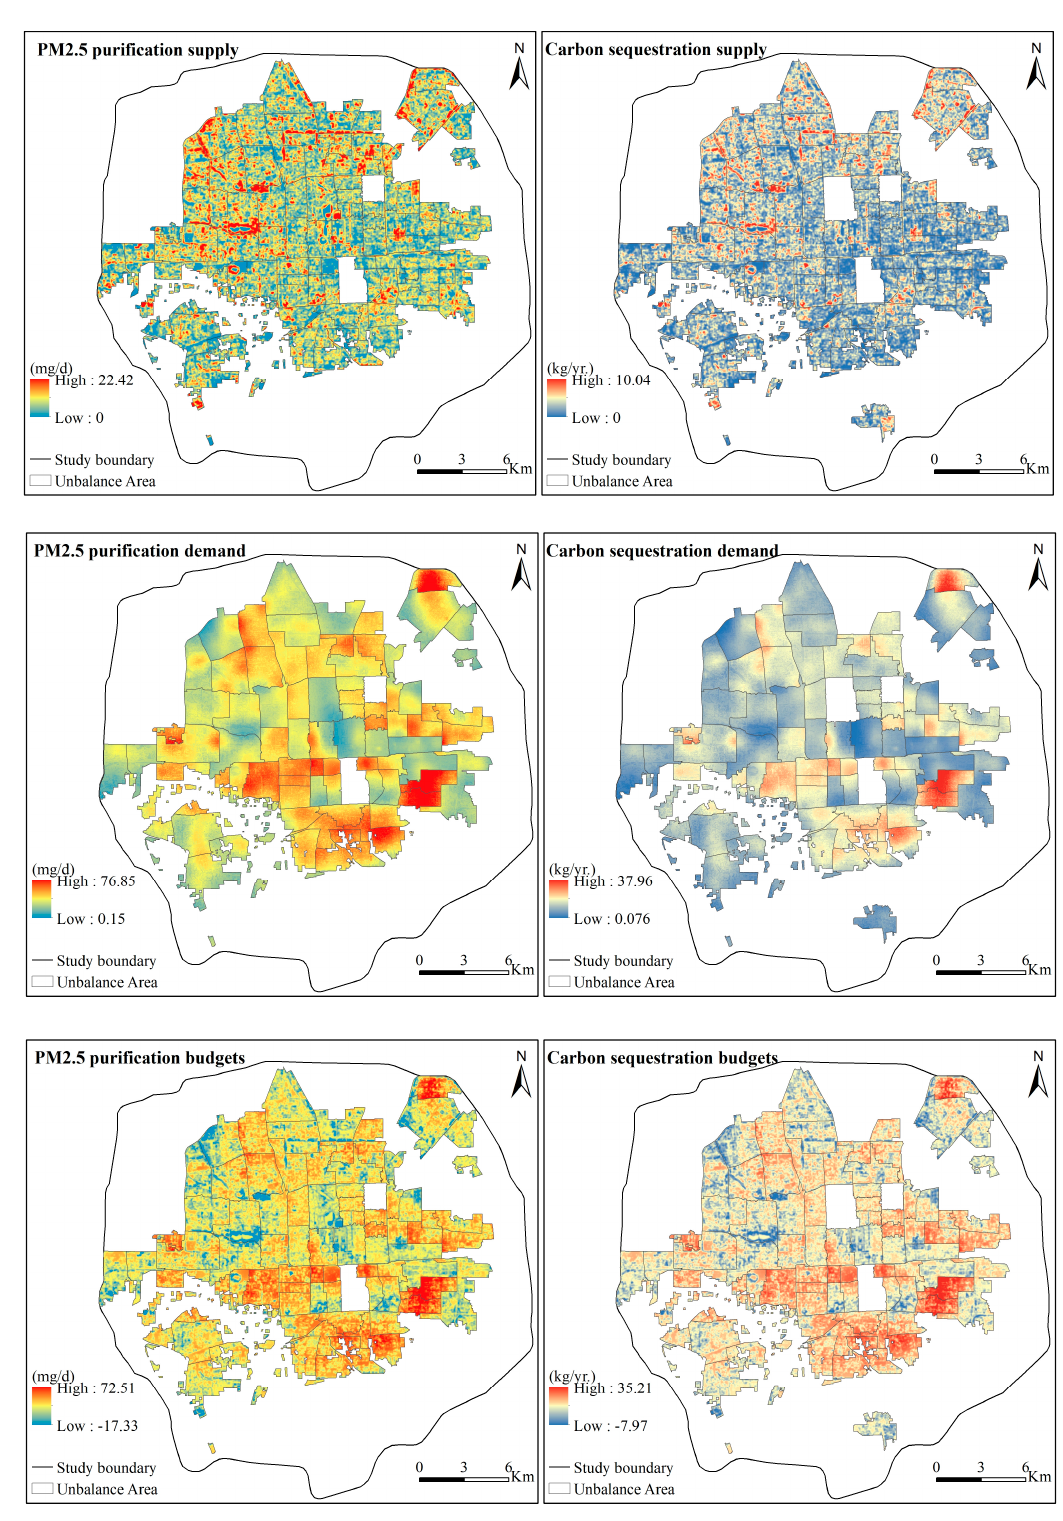
Figure 10. Maps of PM 2.5 purification and carbon sequestration services’ supply and demand and budgets at grid scale for the sub-districts with unbalanced supply and demand.